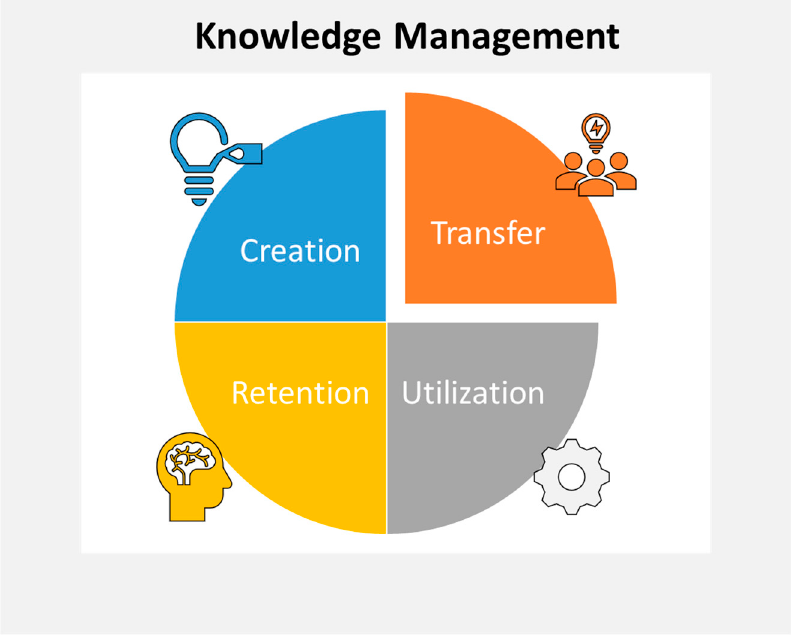
Figure 1. Knowledge management and the four knowledge flows.